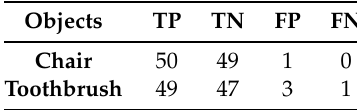
Table 2. Result of object–usage